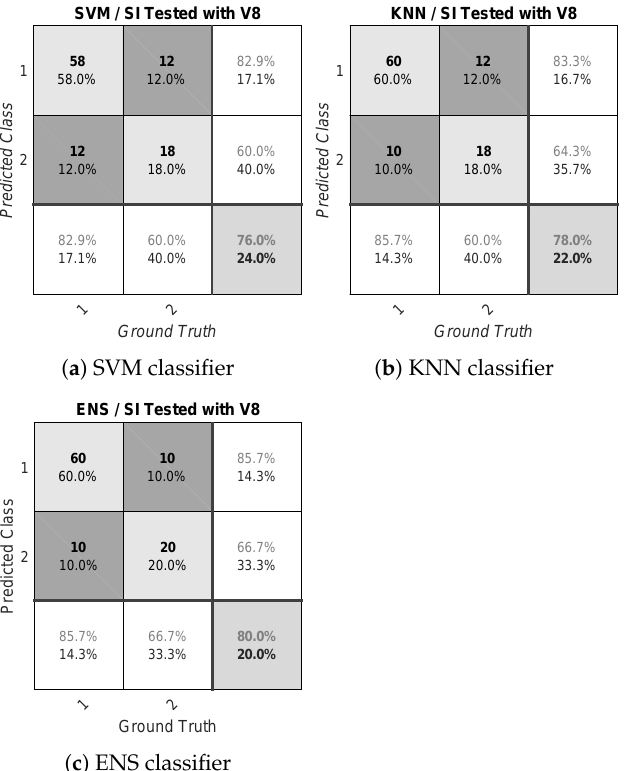
Figure A17. Confusion matrices for a subject-independent model tested with V7.